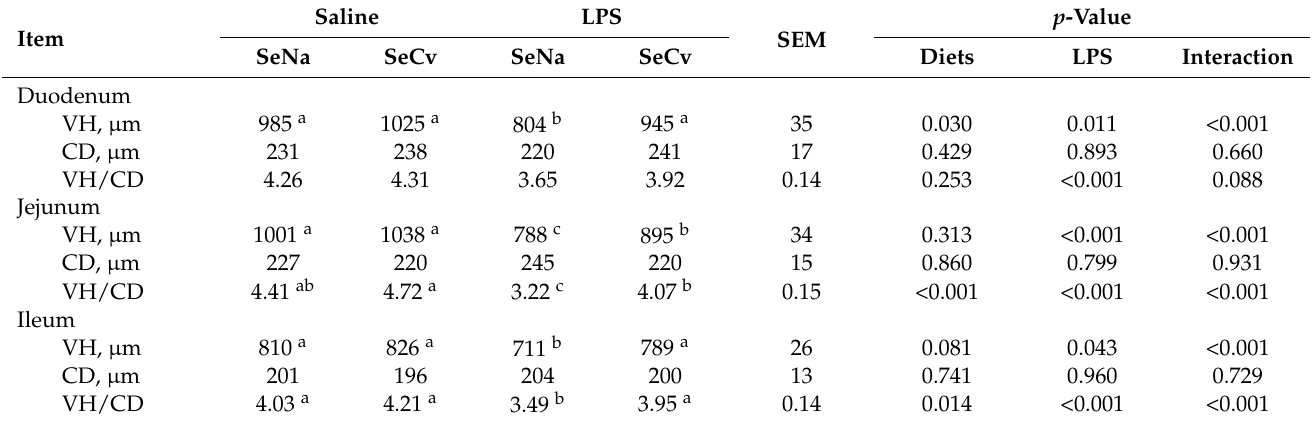
Table 3. Effect of Cardamine violifolia on the intestinal morphology of broilers challenged and unchal- lenged intraperitoneally with